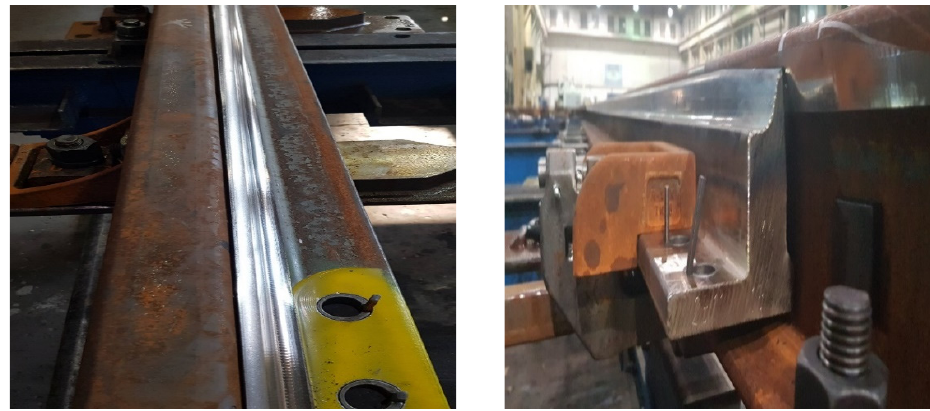
Figure 3. Adhesion of the needle to the stop. Source: own.